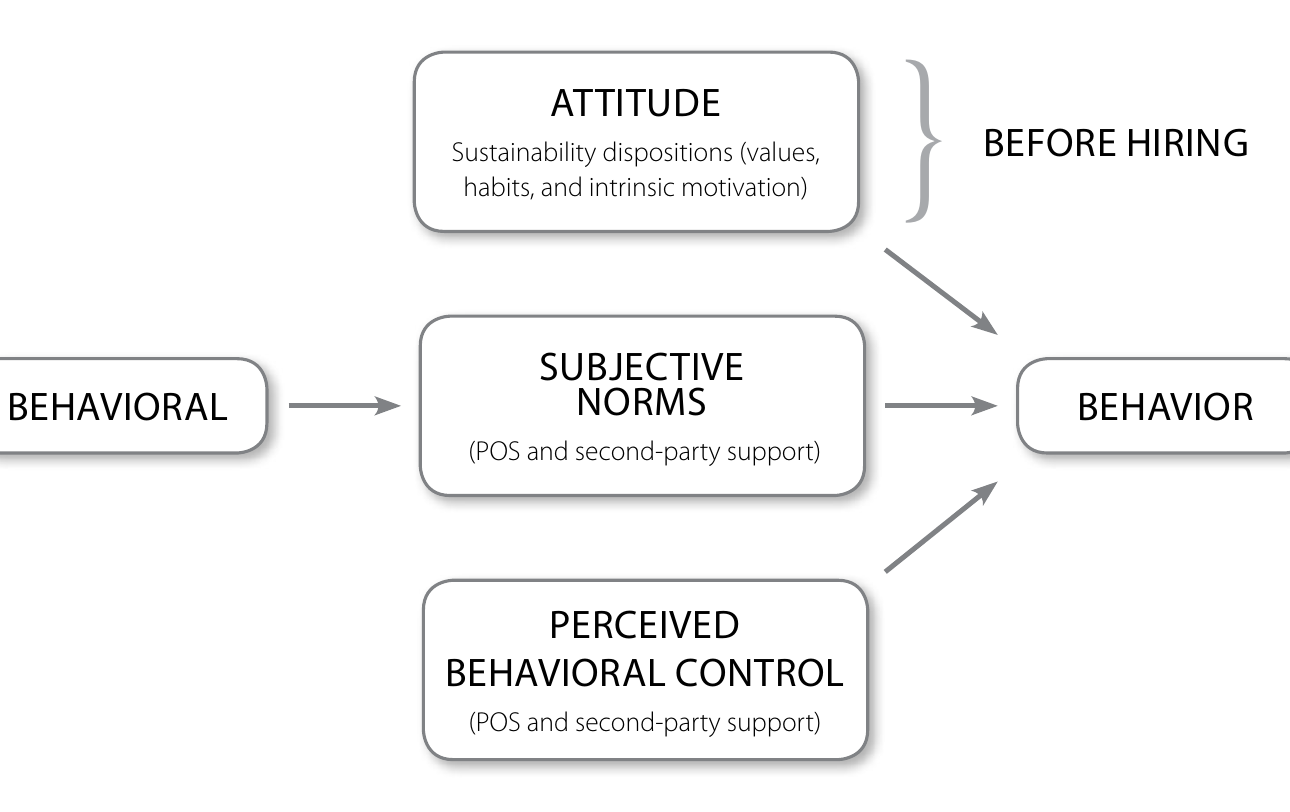
Figure 2. A model of prosocial behaviors for adoption of sustainable practices in